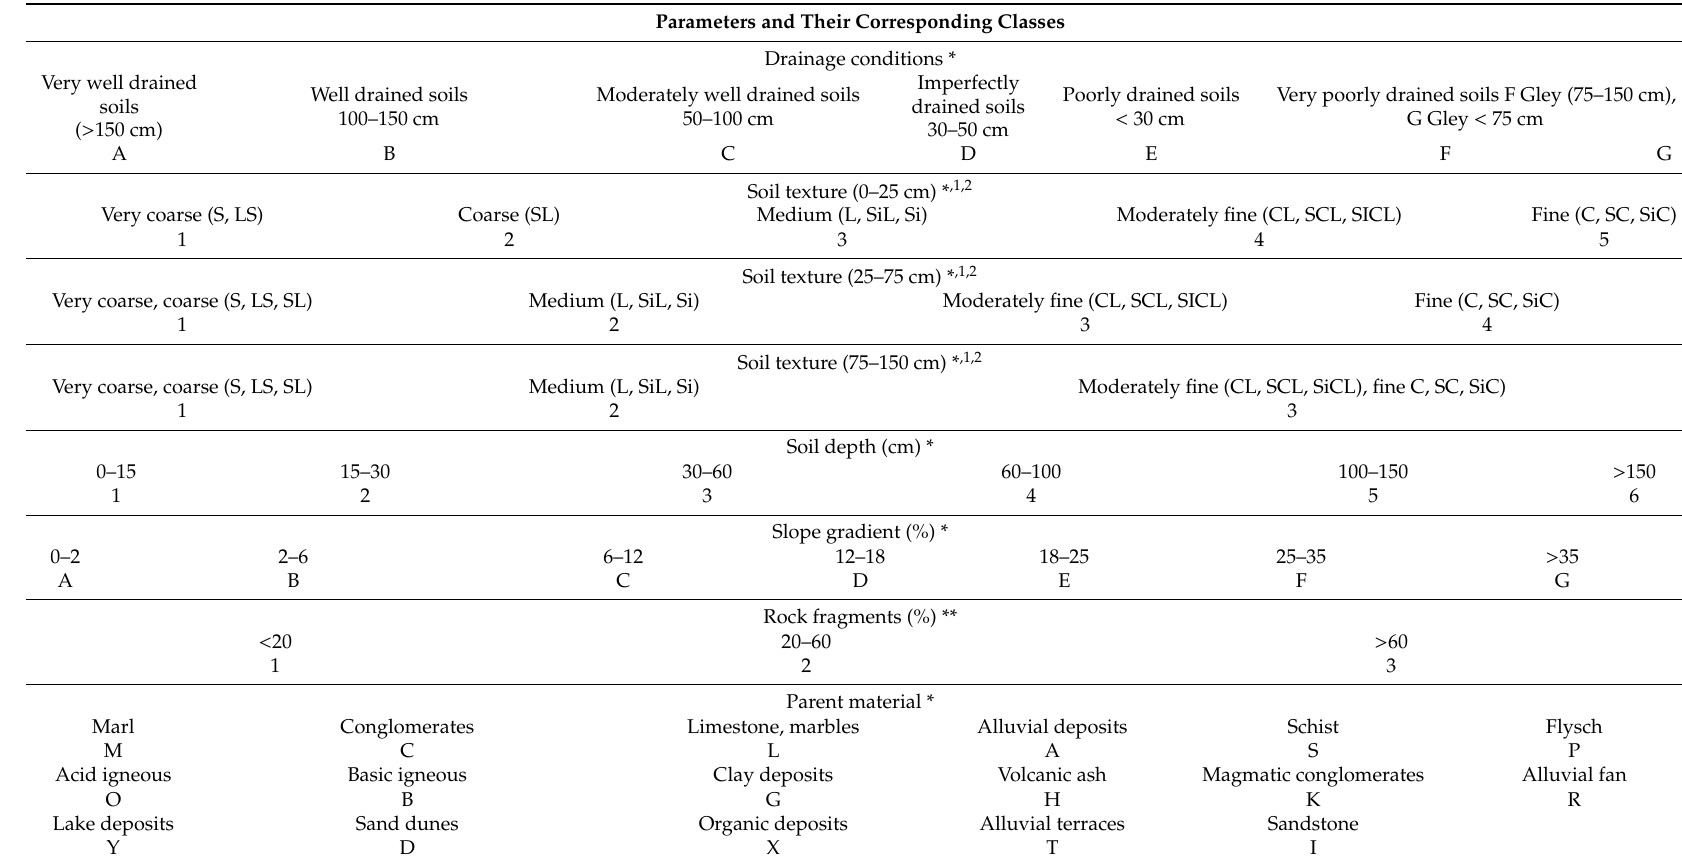
Table A1. Parameters of the conventional and currently applied soil mapping symbol and their corresponding